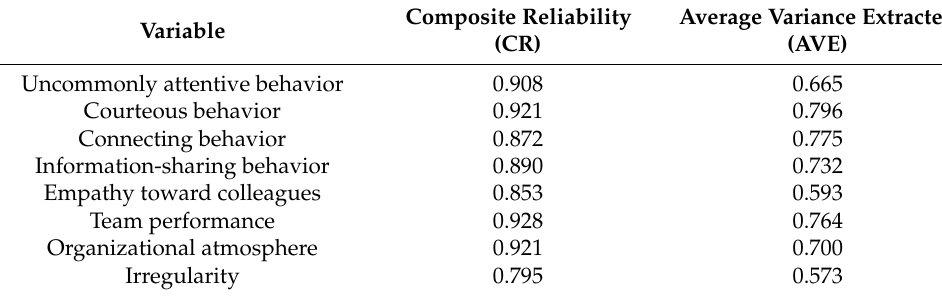
Table 2. Convergent validity